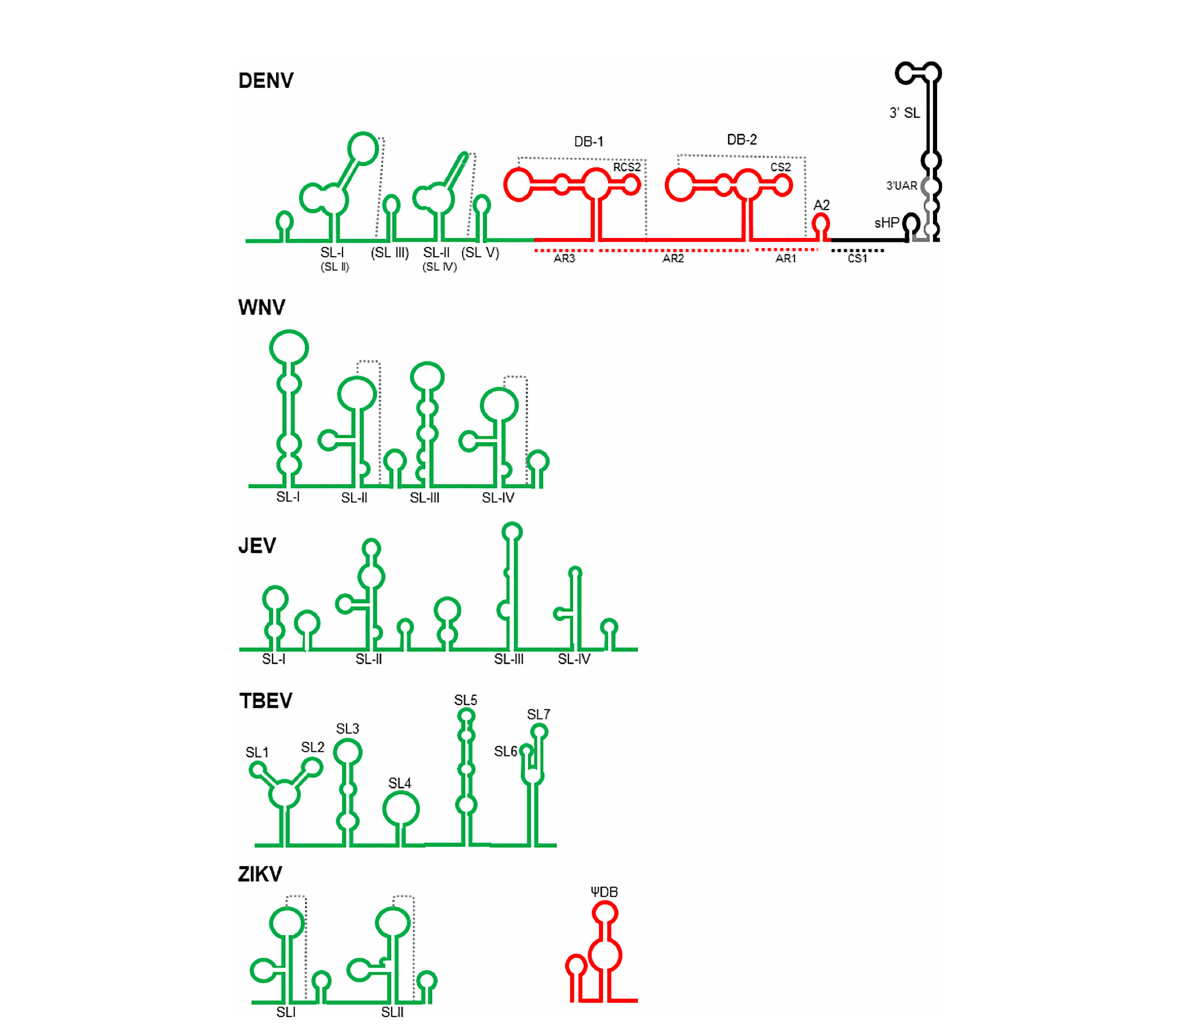
FIGURE 1 Schematic structure of the fl avivirus 3 ’ UTR. The complete 3 ’ UTR of Dengue virus (DENV) is shown according with Olsthoorn and Bol, 2001; Romero et al., 2006; Blaney et al., 2008; Chapman et al., 2014; Kasprzak and Shapiro, 2014; Villordo et al., 2015; Filomatori et al., 2017; Liu et al., 2018; de Borba et al., 2019; Finol and Ooi, 2019, and Bellone et al., 2020. The variable, core and 3 ’ terminal regions are colored in green, red, and black, respectively. SL, stem loops; DB, dumbbells, sHP, small hairpin. The pseudoknots are indicated with dotted lines. The nomenclature referred by Liu et al., 2018 for the stem loops present in the variable region are in parenthesis. The variable regions of West Nile (WNV- Tilgner et al., 2005; Funk et al., 2010; Clarke et al., 2015, and Göertz et al., 2016), Japanese encephalitis (JEV- Chen et al., 2018 and Xing et al., 2021), Tick borne encephalitis (TBEV- Muto et al., 2018 and Sakai et al., 2015) and Zika viruses (ZIKV- Schneider and Wol fi nger, 2019, and Sparks et al., 2020) are shown. Additionally, the fi rst dumbbell structure of ZIKV (Schneider and Wol fi nger, 2019) is also